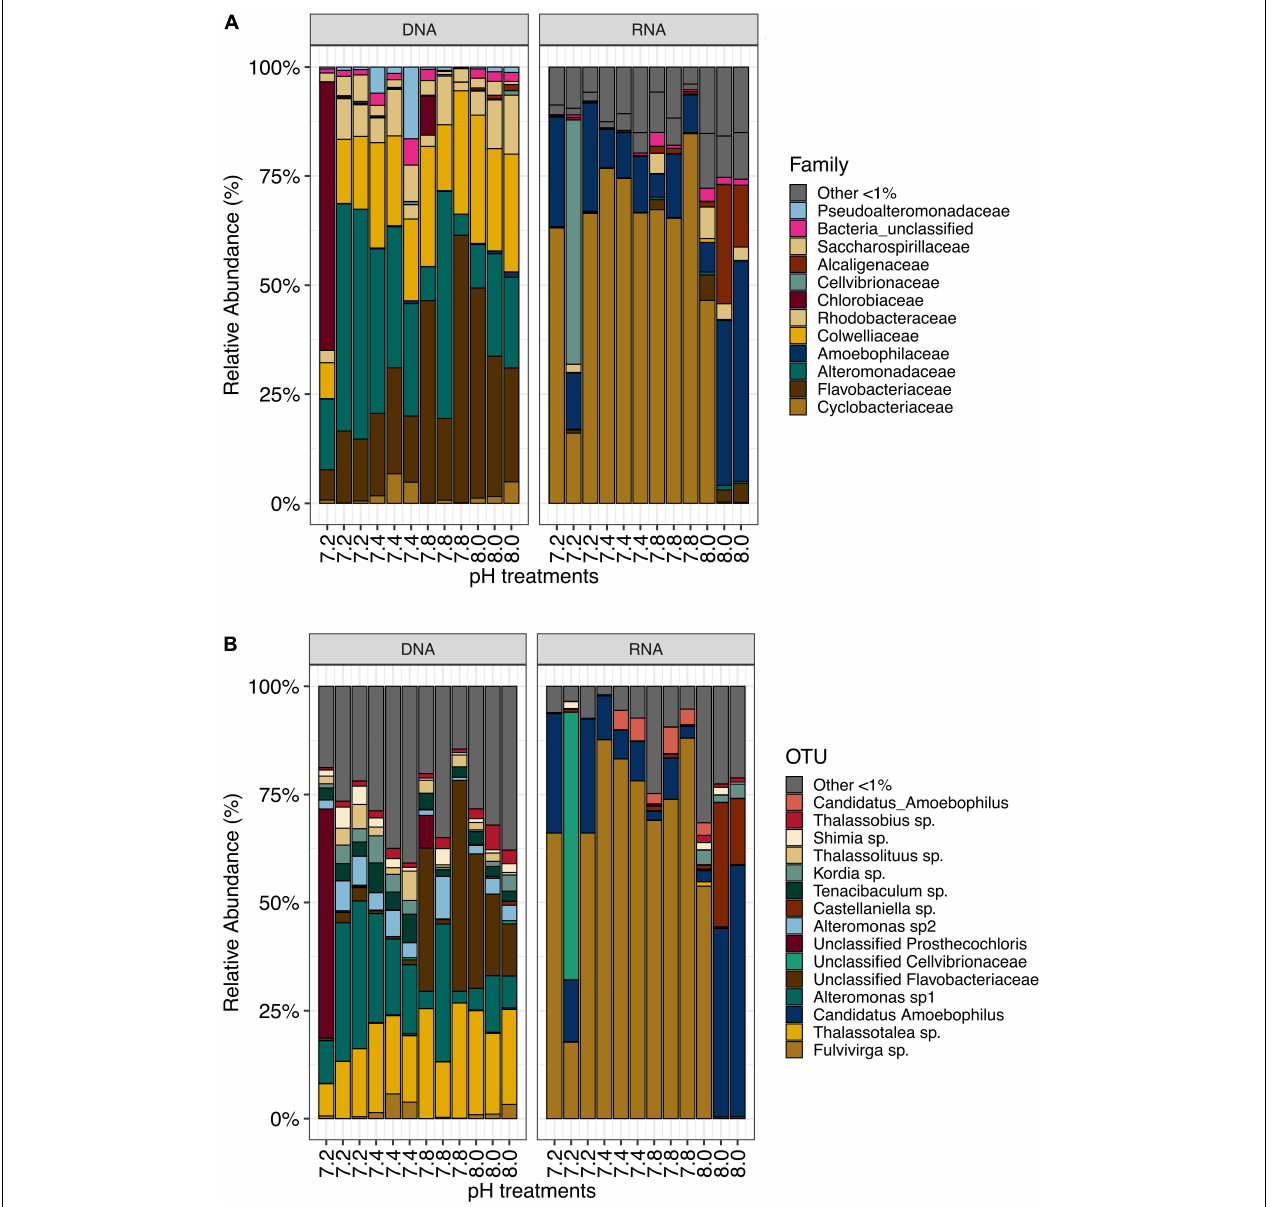
FIGURE 1 | (A) Most abundant bacterial families ( > 1%) and (B) OTUs in samples from Stylophora pistillata kept in aquaria for 2 years at different pH treatments (pH 7.2, 7.4, 7.8 and 8.0), after subsampling to 10,669